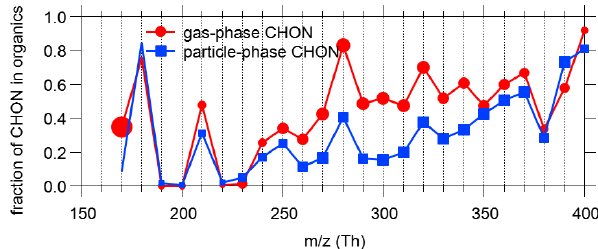
Figure 14. The average fractions of CHON to total organic com- pounds (CHO + CHON + CHOS + CHONS) of every 10Th in both phases. See Fig. S16 for the overall distribution of the contri- butions of species classes to the total concentrations. Marker sizes indicate the total concentration level in each m/z bin. High am- bient concentration of HNCO resulted in the large marker around m/z 170 in the gas phase (Z. Wang et al.,